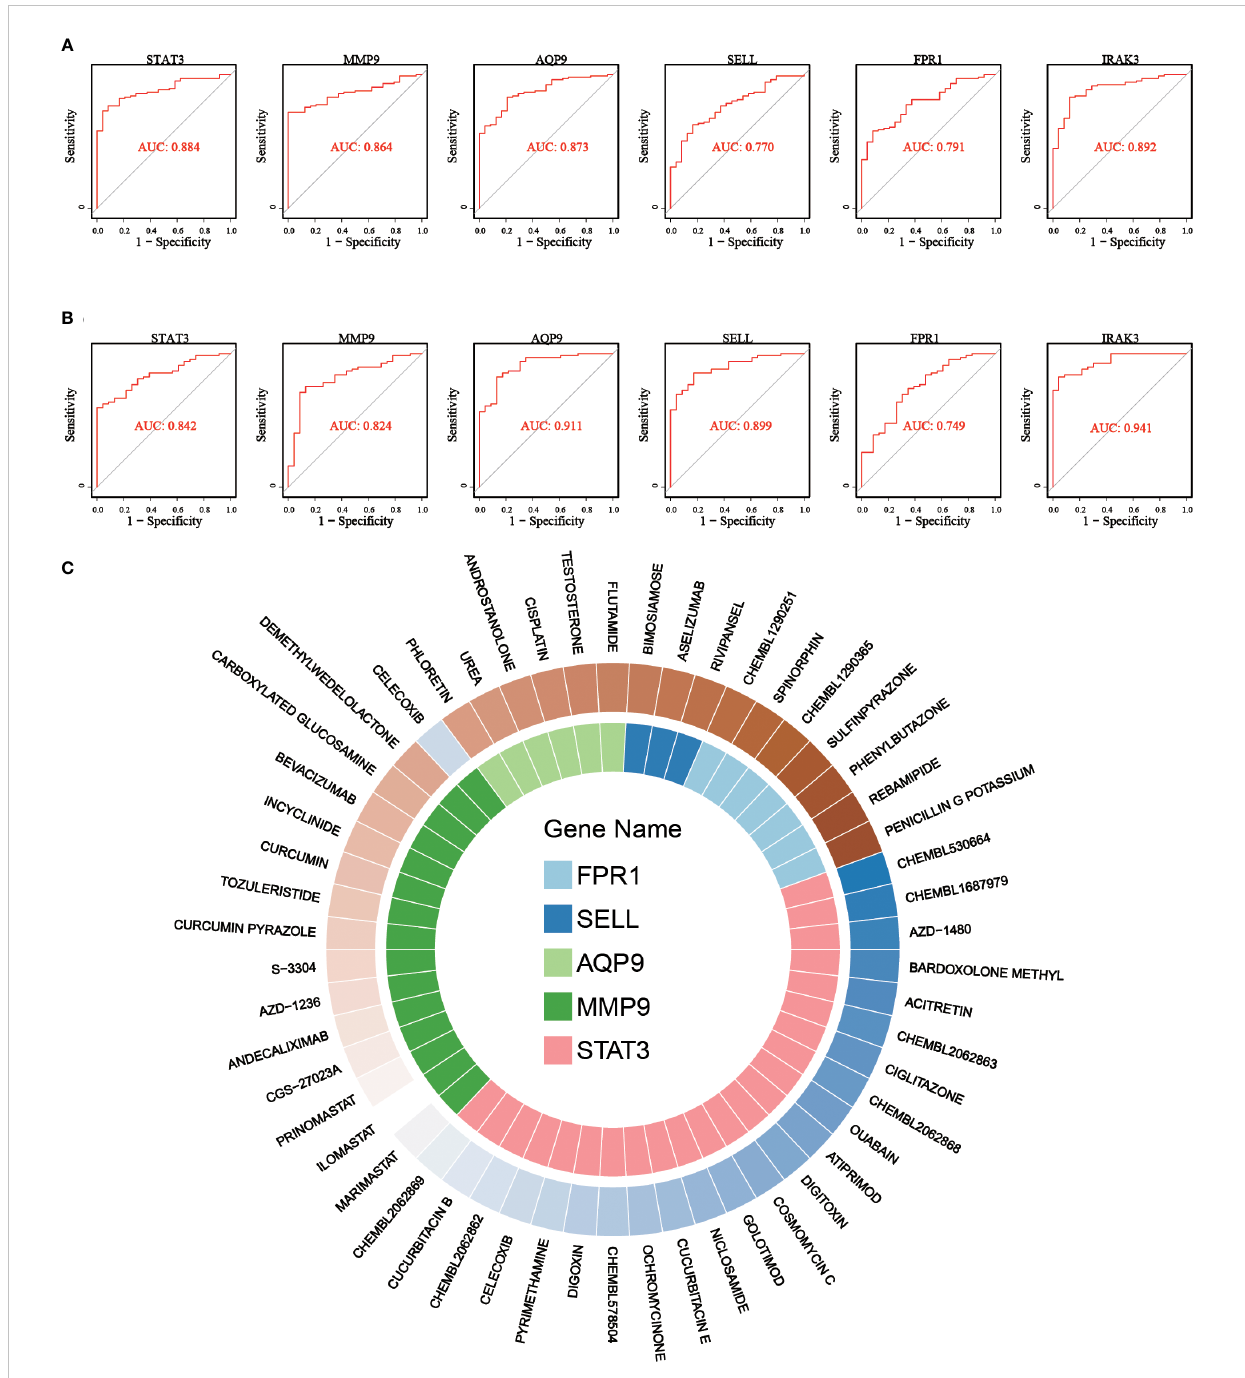
FIGURE 8 ROC curves for diagnostic performance evaluation and gene-drug interaction relationship for critical genes. (A) ROC curves of 6 critical genes in discovery dataset. (B) ROC curves of 6 critical genes in validation dataset. (C) Drug-gene network showing the potential interactions between 5 critical genes and 53 predicted targeted